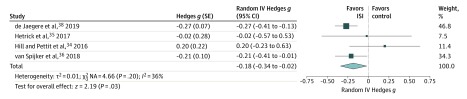
Between-Group Effects of Internet-Based Self-help Interventions (ISIs) on Suicidal Ideation at Follow-upFollow-up occurred 6 to 26 weeks after the postintervention period. Negative values indicate lower suicidal ideation in the intervention group compared with controls. Size of markers indicates weight. IV indicates inverse variance; NA, not applicable; and SE, standard error.